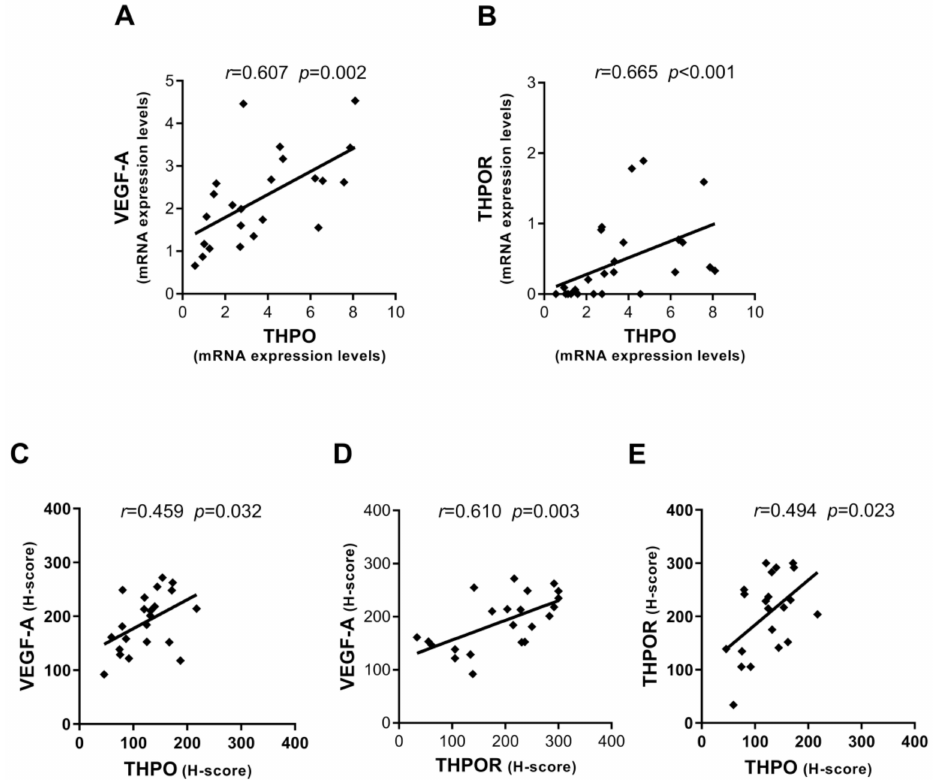
Figure 5. Interrelationships between mRNA and protein expression levels of THPO, VEGF-A, and THPOR in HCC. Correlations between mRNA expression levels of THPO and VEGF-A ( A ) and THPO and THPOR ( B ). Correlations between protein expression in IHC staining (H-score) of THPO and VEGF-A ( C ), THPOR and VEGF-A ( D ), and THPO and THPOR ( E ). Analyses by Pearson ( A – E ) or Spearman ( B ) correlation tests; correlation coefficient r and p values are also